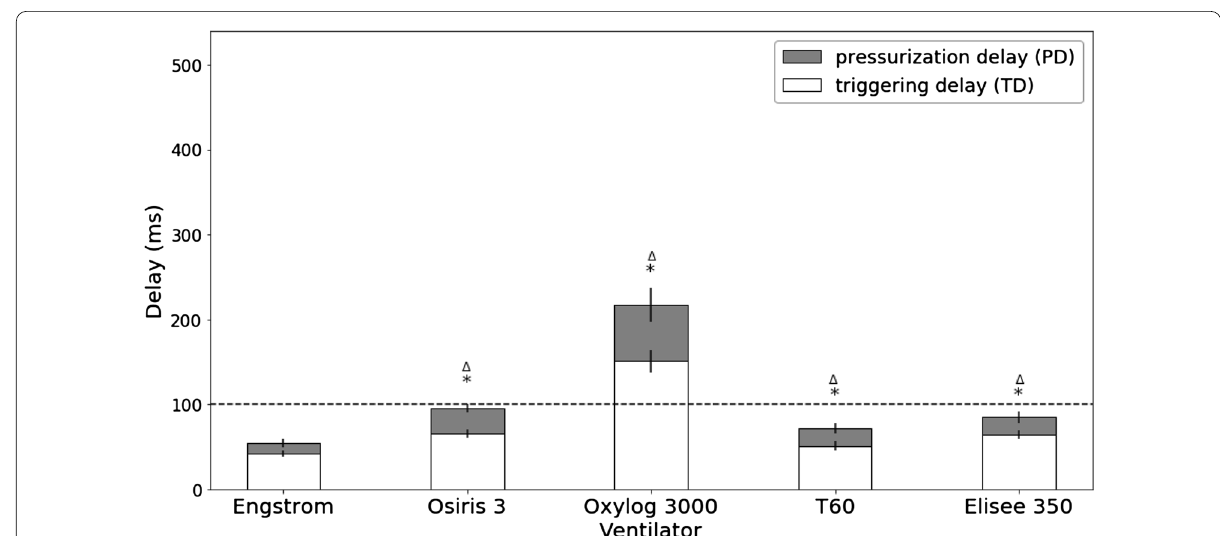
Fig. 5 Triggering characteristics in volume assist‑control ventilation for a P0.1 of 4 cmH 2 O. The figure illustrates the triggering efficiency for each ventilator tested during assist‑control ventilation using the Michigan test lung to simulate spontaneous breathing. A moderate effort was achieved, corresponding to a decrease in airway pressure 100 ms after occlusion (P0.1) of 4 cmH 2 O was achieved. A PEEP of 10 cmH 2 O, a compliance of 20 and 50 ml/cmH 2 O and a resistance of 15 cmH 2 O/l/s were selected. Triggering Delay (TD, ms) and Pressurization Delay (PD, ms) were computed. A definition of TD and PD is available on Fig. 1. Triggering function was considered safe and acceptable when TD was less than 100 ms. * p < 0.005 for TD when comparing each transport ventilator with the Engstrom ICU ventilator (ANOVA test: global F was significant). Δ p < 0.005 for PD when comparing each transport ventilator with the Engstrom ICU ventilator (ANOVA test: global F was